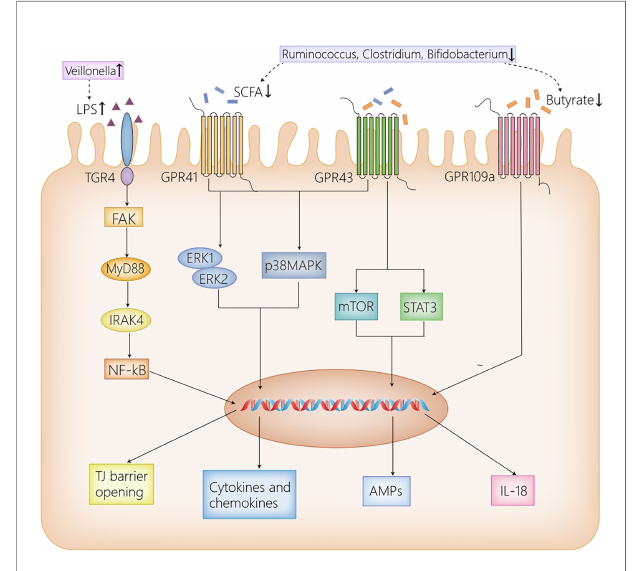
FIGURE 1 | The receptor pathways in the intestine. High dose LPS induced by the increased abundance of Veillonella in AIH activates TLR4 expressed on IECs, then leads to the phosphorylation and activation of FAK, which regulates the activation of MyD88 and IRAK4, ultimately disrupting